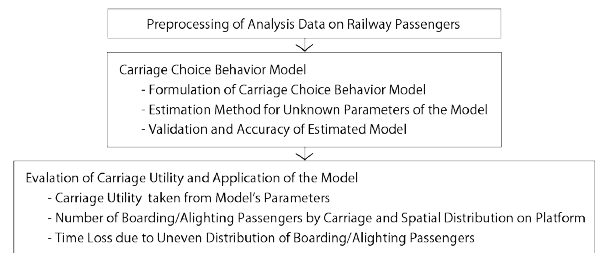
Figure 1 . Overall flowchart of the